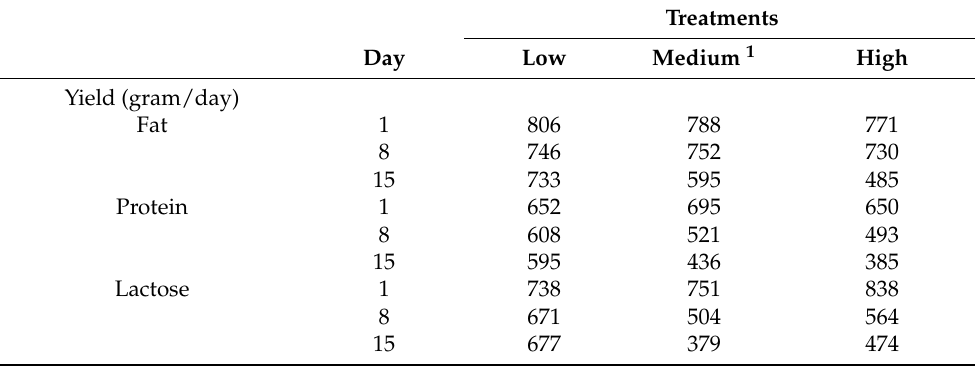
Table 6. Milk production and composition of dairy cows at several days (relative to the first day of offering the seaweed mix containing A. taxiformis ) during the experimental